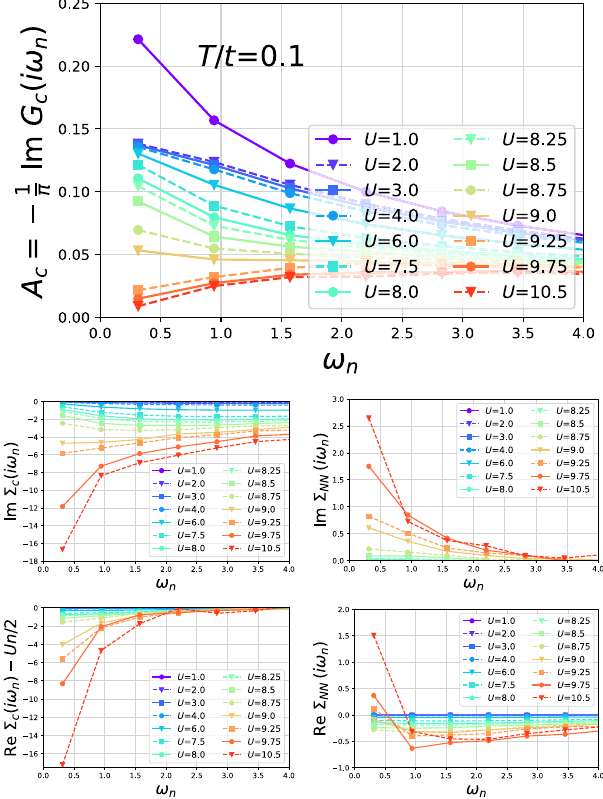
FIG. 17. Top: spectral weight A c expressed with the imaginary part of the Green function on the central site of CDMFT at T=t ¼ 0 . 1 for several interaction values as a function of the Matsubara frequency. Center: imaginary part of the self-energy on the central site (left) and to its nearest neighbor (right). Bottom: real part of the self-energy on the central site (left, the Hartree term has been subtracted here) and to its nearest